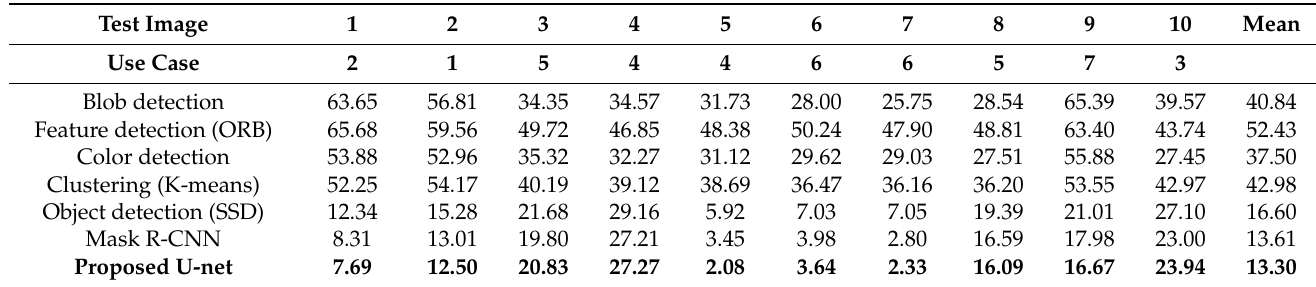
Table 7. Comparison of the proposed approach (in bold) with other computer vision baselines and machine learning methods using total percentage of misidentifications as a metric (sum of false positives and false negatives). Test